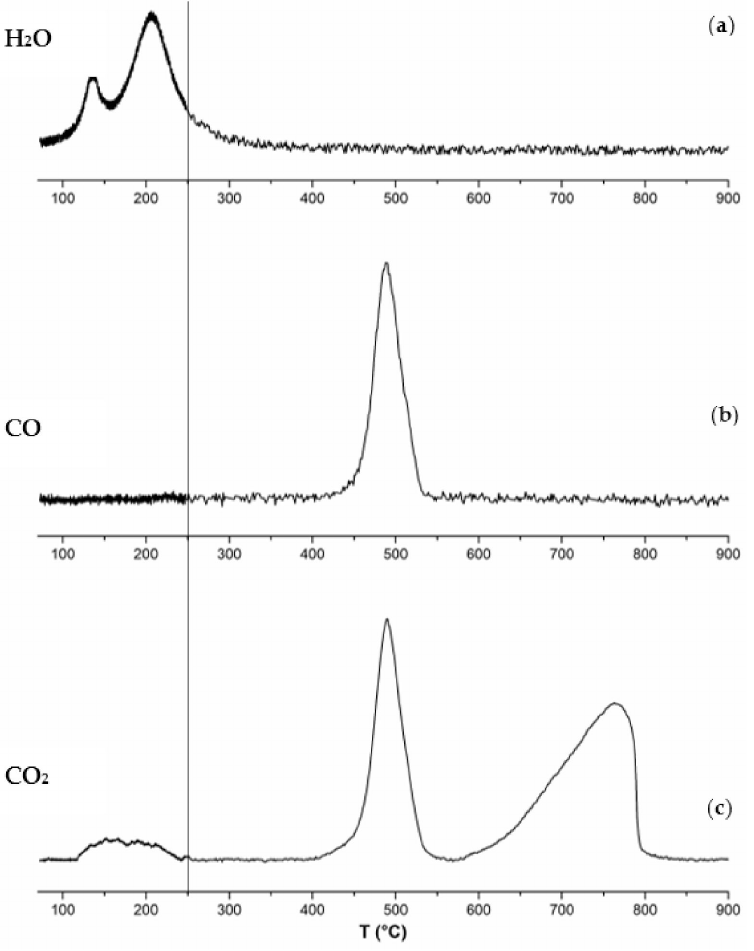
Figure 5. FTIR measurements of ( a ) H 2 O, ( b ) CO, and ( c ) CO 2 release. The darker color of the experimental data on the left of the vertical line (low-temperature range) is related to the slow-rate ramp (2 ◦ C/min), at a temperature higher than 250 ◦ C, the ramp rate was increased to 15 ◦ C/min to simulate the heating condition of an industrial